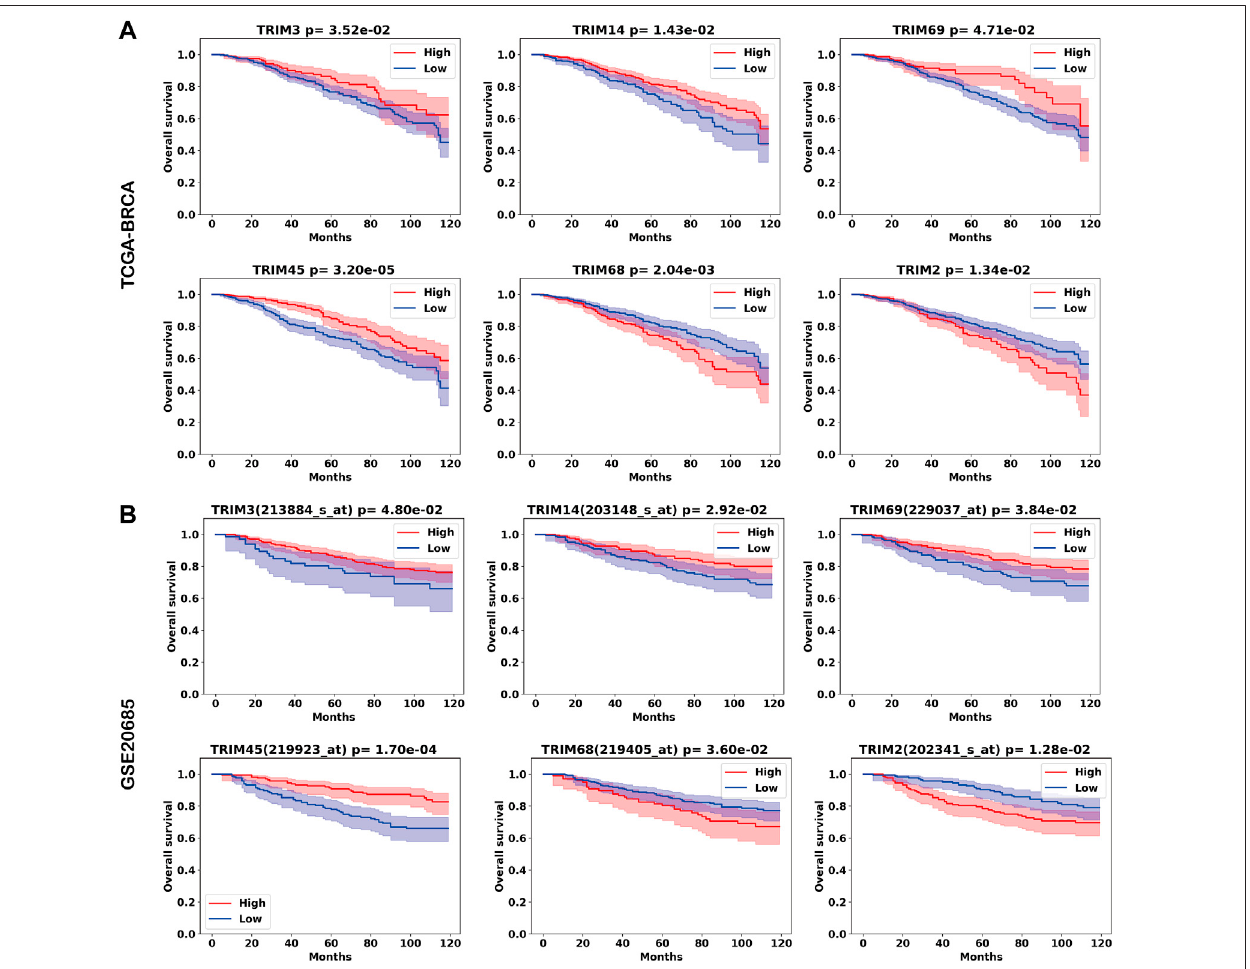
FIGURE3| Tripartitemotif(TRIMs)associatedwiththeprognosisofBC.TheKaplan – Meiercurvesforgenes TRIM3/14/69/45/68/2 in (A) TCGA-BRCAcohortand (B) the GSE20685 cohort.